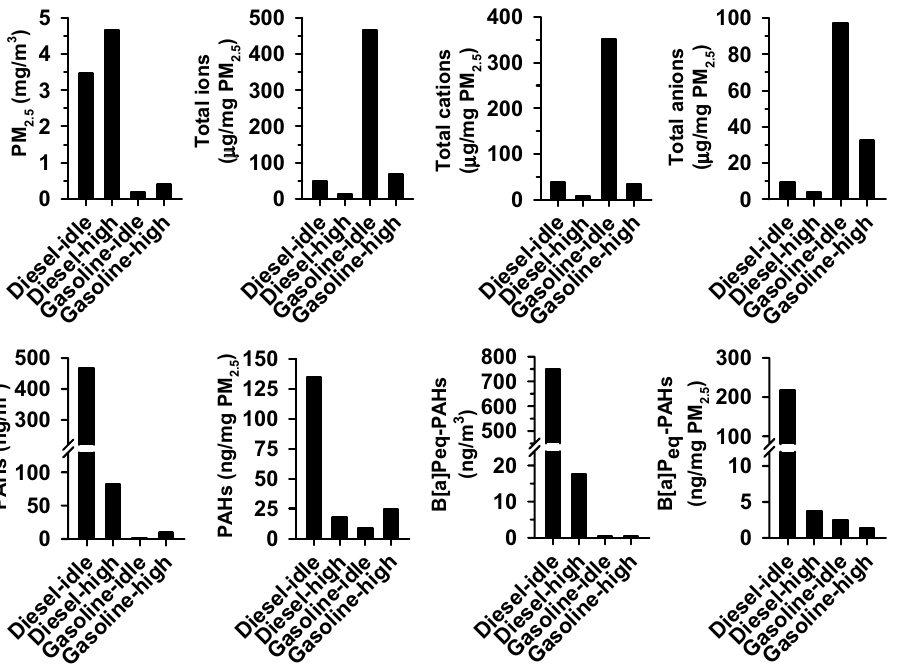
Figure 2. The influence of speed and diesel type on the composition and B[a]P toxicity equivalents (B[a]Peq) of PM 2.5 in the exhausts. Exhausts were collected from trucks with gasoline or diesel engine under idle and high (70 km/h) speeds and the PM 2.5 content and the total contents of ions and PAHs (∑ 24-27 PAHs) in PM 2.5 particulates were quantitated as described in the